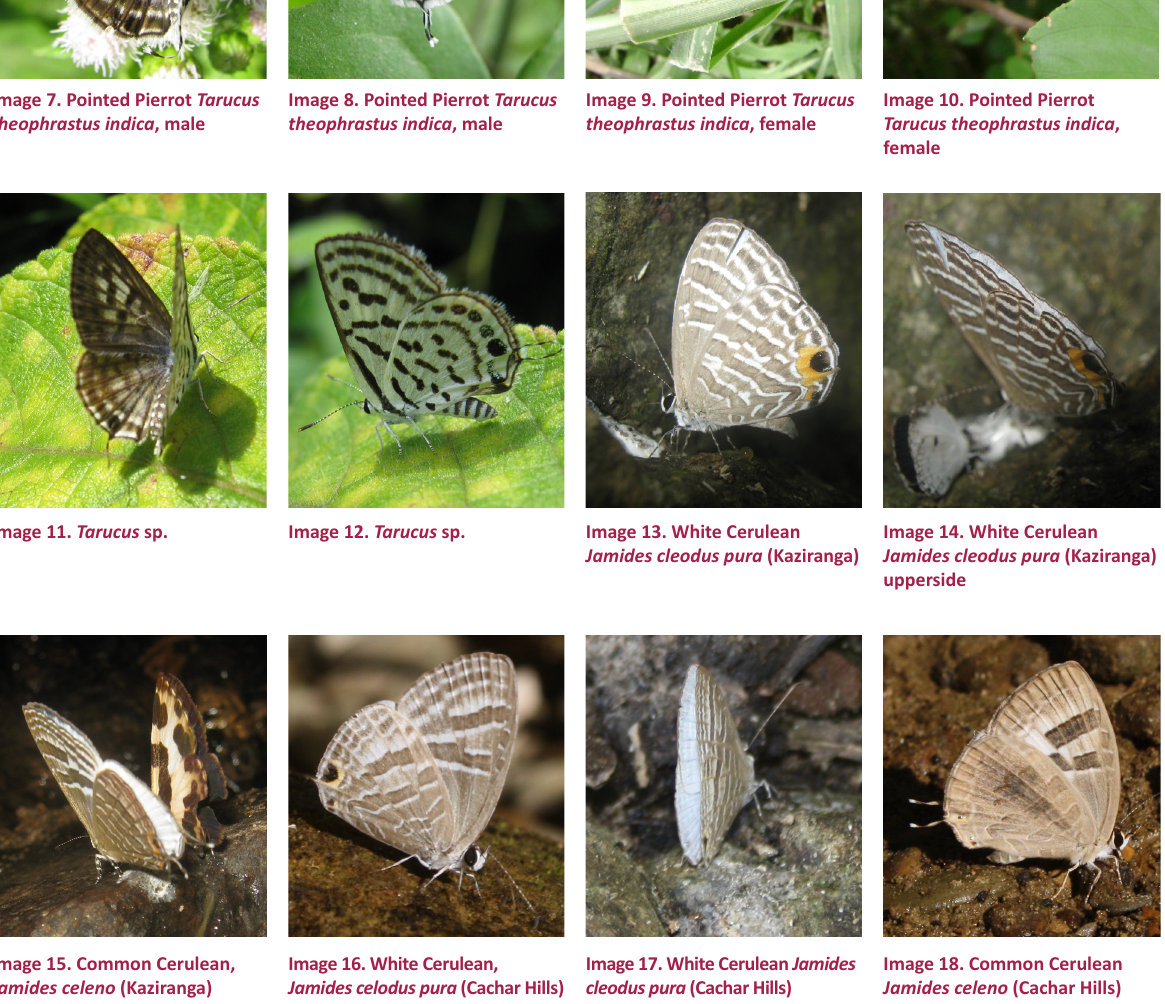
Image 17. White Cerulean Jamides cleodus pura (Cachar